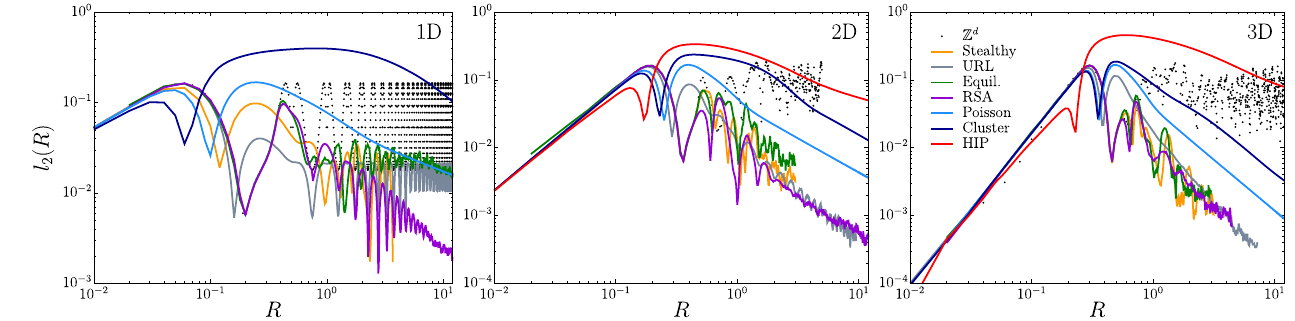
FIG. 5. Gaussian distance metric l 2 ð R Þ versus the window radius R for all considered models across the first three space